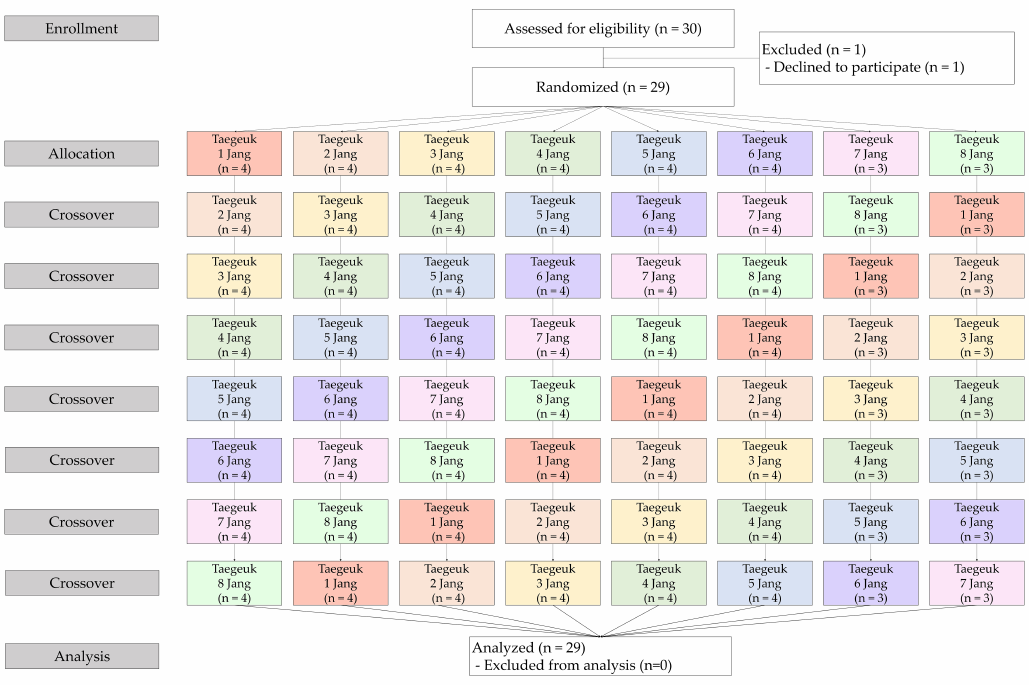
Fig. 2. Consolidated Standards of Reporting Trials (CONSORT) flow